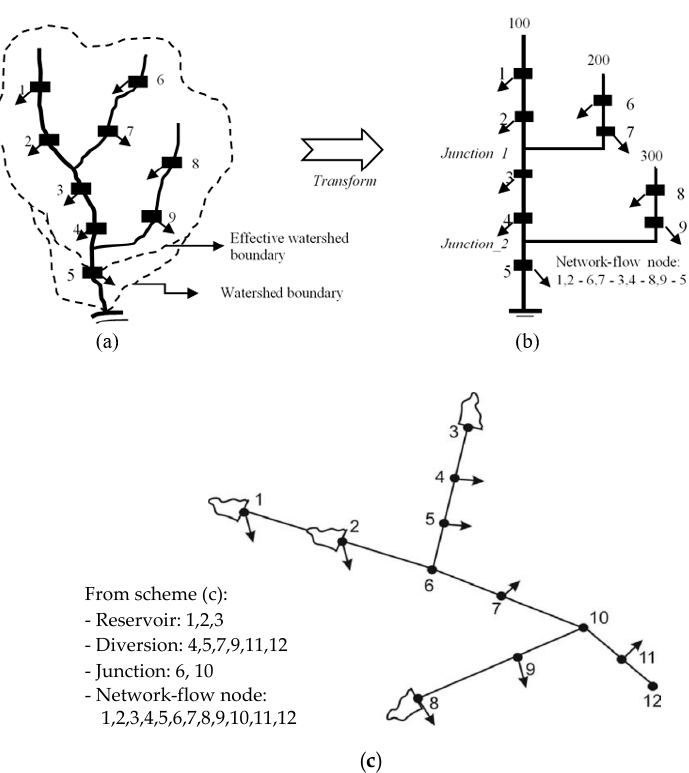
Figure 4. Transformation sketch from map to the scheme in Independent River. ( a ) Watershed map with headwork nodes; ( b ) River scheme (MEQAA version); ( c ) River scheme (Wurbs version).